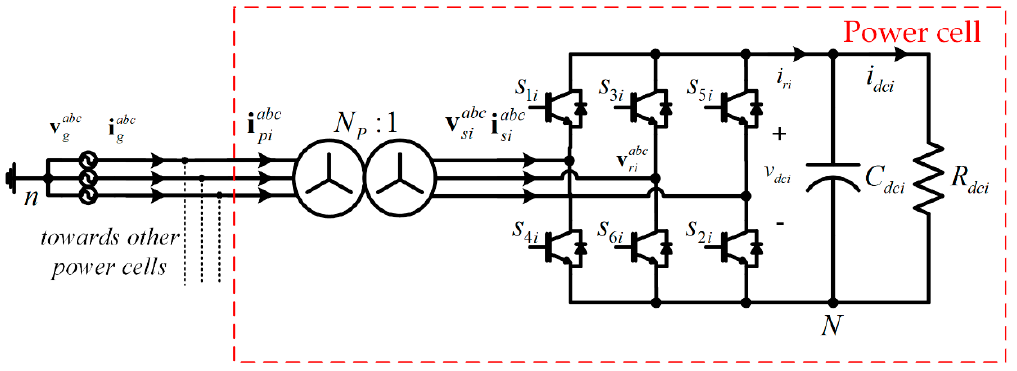
Figure 4. Power cell in multicell AFE